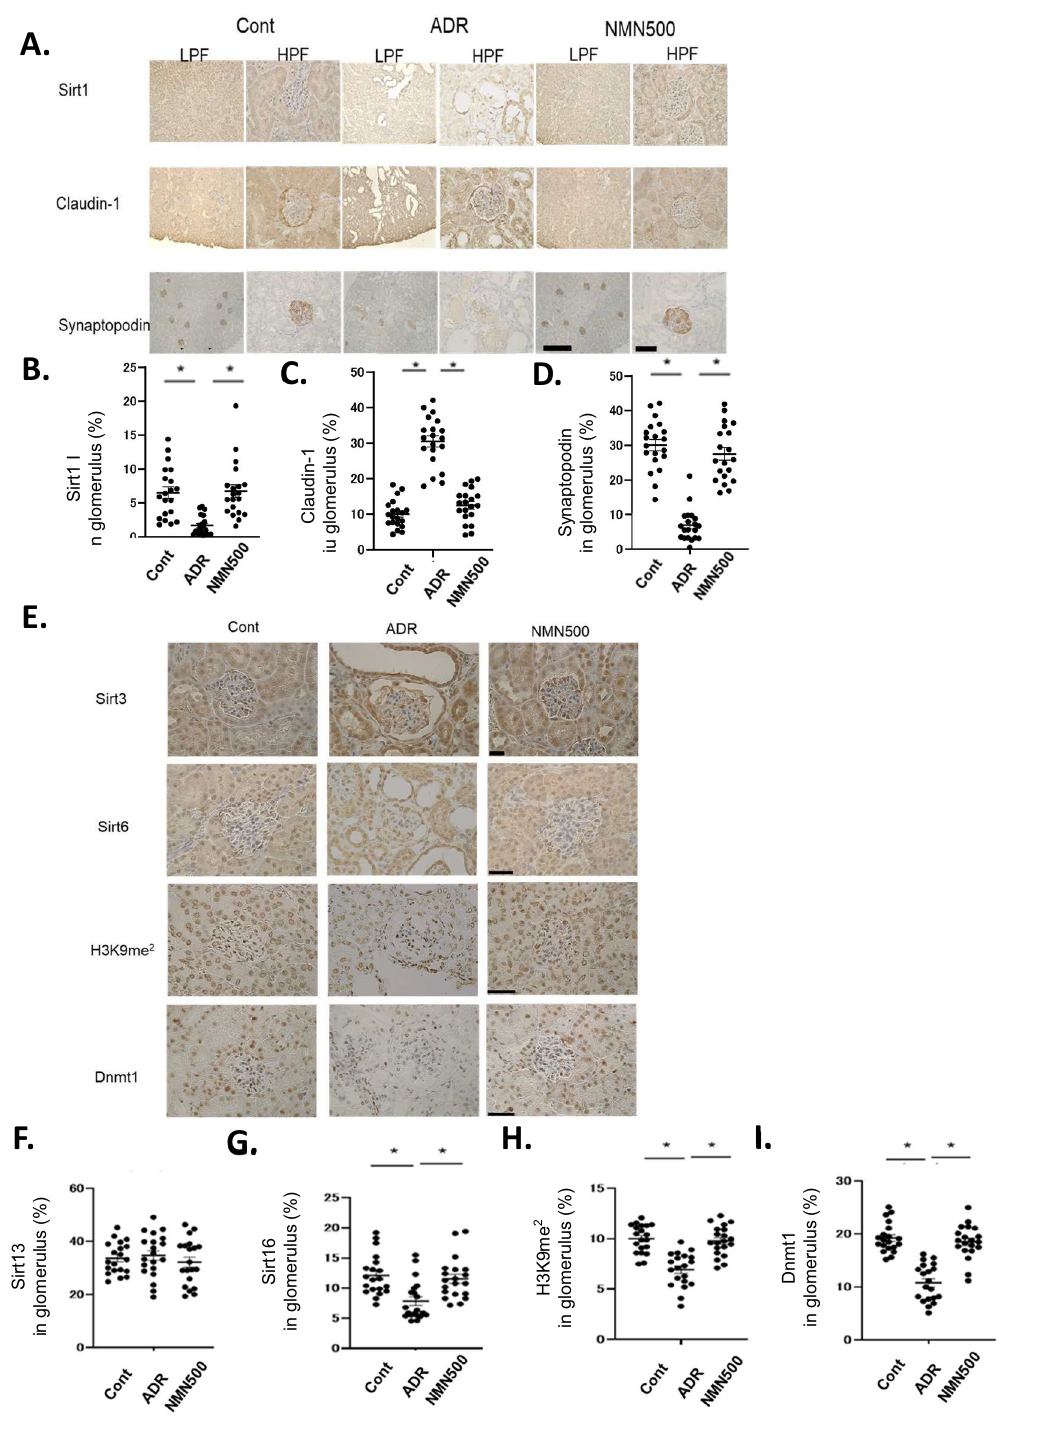
Figure 5. Molecular changes in the glomerulus after NMN treatment. ( A ) Representative images showing immunostaining for Sirt1, Claudin-1, and Synaptopodin in the glomeruli of the animals in the Cont, ADR, and NMN500 groups. Left, low-magnification images (scale bar 50 µm); right, high-magnification images (scale bar 500 µm). ( B–D ) The proportional areas of Sirt1 ( B ), Claudin-1 ( C ), and Synaptopodin ( D) staining ( n = 20 sections per group). ( E ) Representative images showing immunostaining for Sirt3, Sirt6, H3K9me2, and Dnmt1 in the glomeruli (scale bar 50 µm). ( F–I ) The proportional areas of Sirt3 ( F ), Sirt6 ( G ), H3K9me2 ( H ), and Dnmt1 ( I ) staining determined by the Image-Pro Plus 7.0J software ( n = 20 sections per group). All data are shown as mean ± standard error of the mean. Statistical significance between each group is represented by a horizontal bar. * P < 0.05 by ANOVA with Tukey’s post hoc